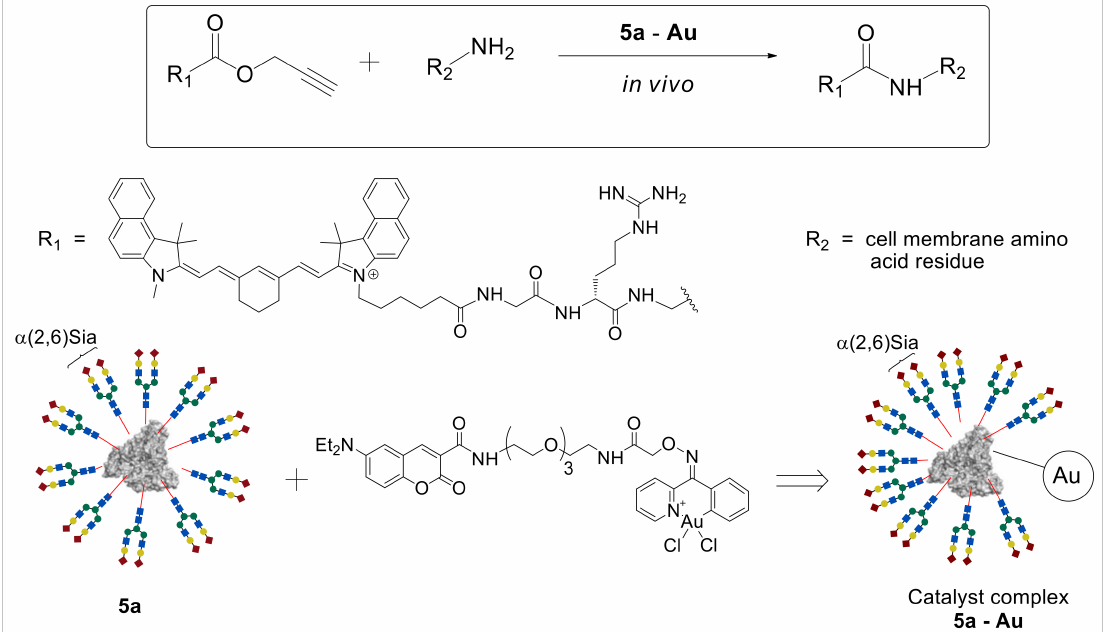
Figure 4. Reaction between fluorescent propargyl ester and amino groups of the surface cell mem- brane catalyzed by the homogeneous glycoalbumin based 5a – Au